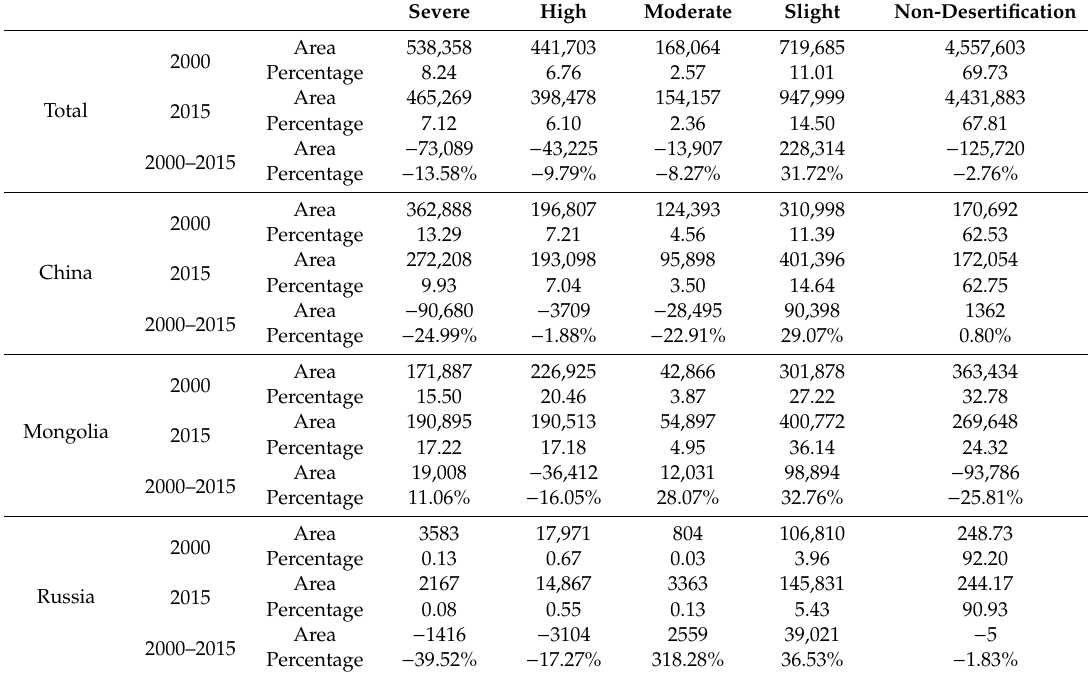
Figure 4. Spatial distribution of desertification degrees in 2000 ( a ) and 2015 ( b ). Table 7. The changes in desertification degrees from 2000 to 2015 (area: km 2 ; percentage: %). Severe High Moderate Slight